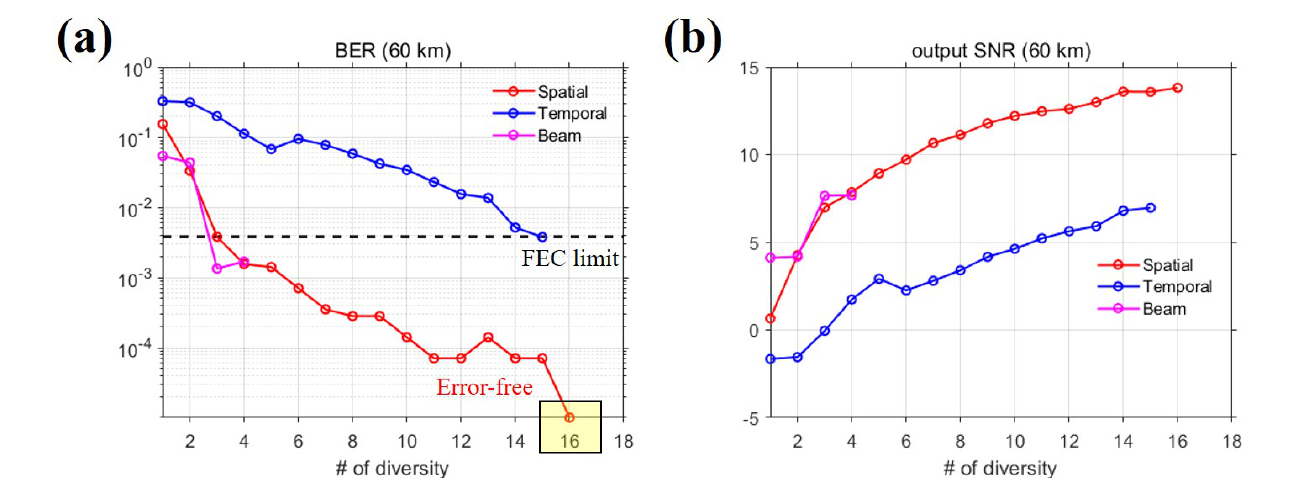
Figure 9. Variation in performance as a function of the order of diversity: ( a , b ) present the BER and output SNR results for the three diversity methods, respectively. The red, blue, and magenta solid lines with circles as markers represent the spatial, temporal, and beam diversity methods,